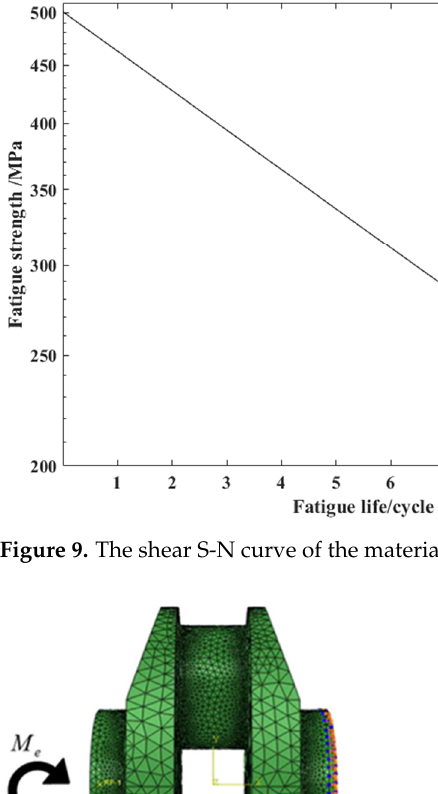
Figure 9. The shear S-N curve of the material.